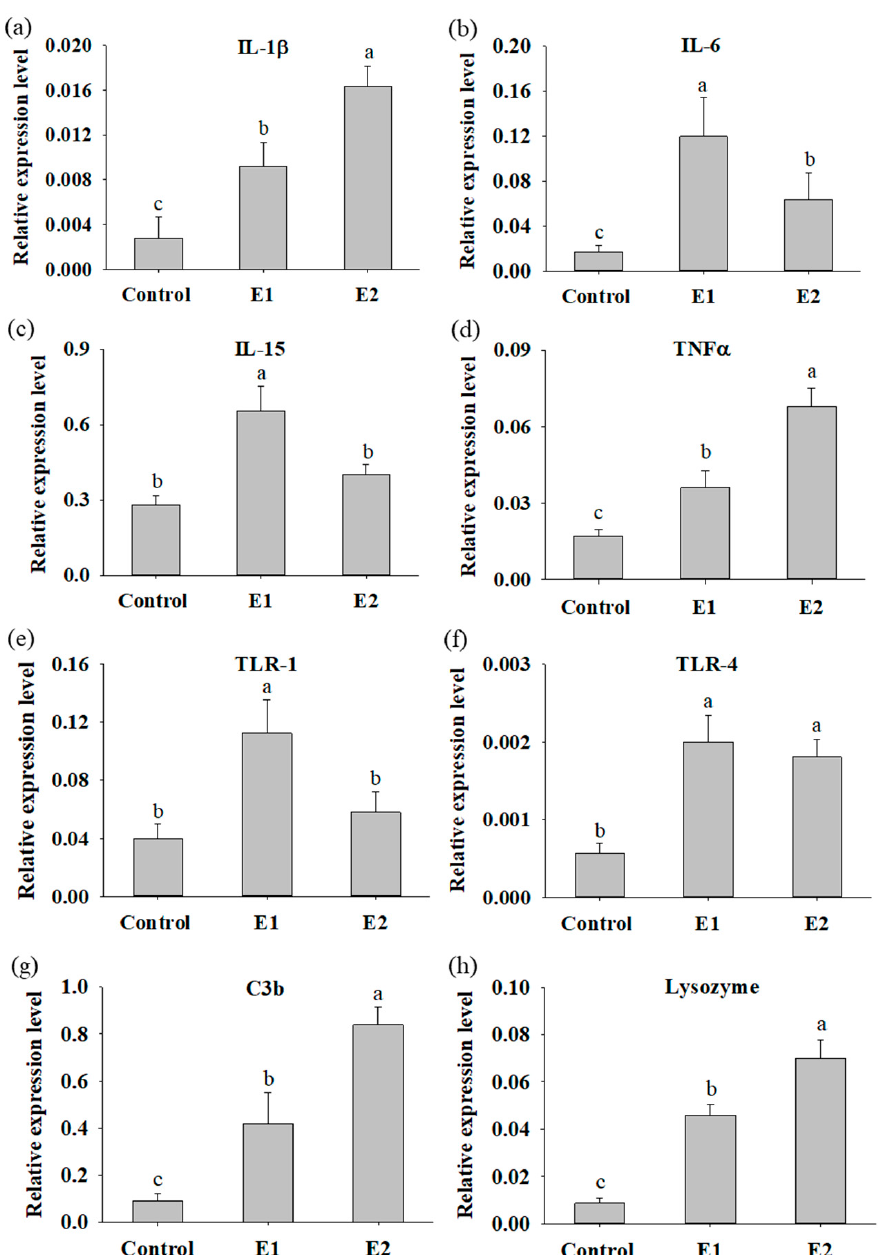
Figure 4. Quantitative PCR analysis of immune-related expression in zebrafish fed the basal diet (control), the basal diet containing 10 6 (E1) or the basal diet containing 10 7 (E2) CFU/g P. ehimensis NPUST1 for 8 weeks. Expression of IL-1 β ( a ), IL-6 ( b ), IL-15 ( c ), TNF α ( d ), TLR-1 ( e ), TLR-4 ( f ), C3b ( g ) and lysozyme ( h ) in the whole body. The results represent the mean ± S.D. of six fish per group. Bars with different superscripts are significantly different ( p < 0.05, one-way ANOVA, Tukey’s multiple comparisons test).